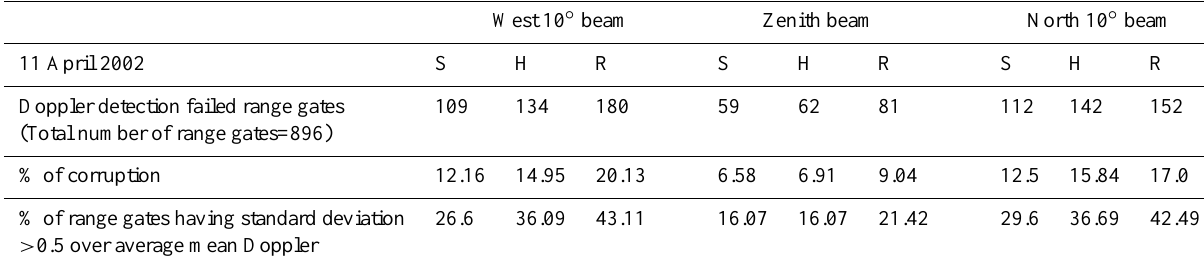
Table 2. Same as the case for Table 1 but for the observation on 11 April